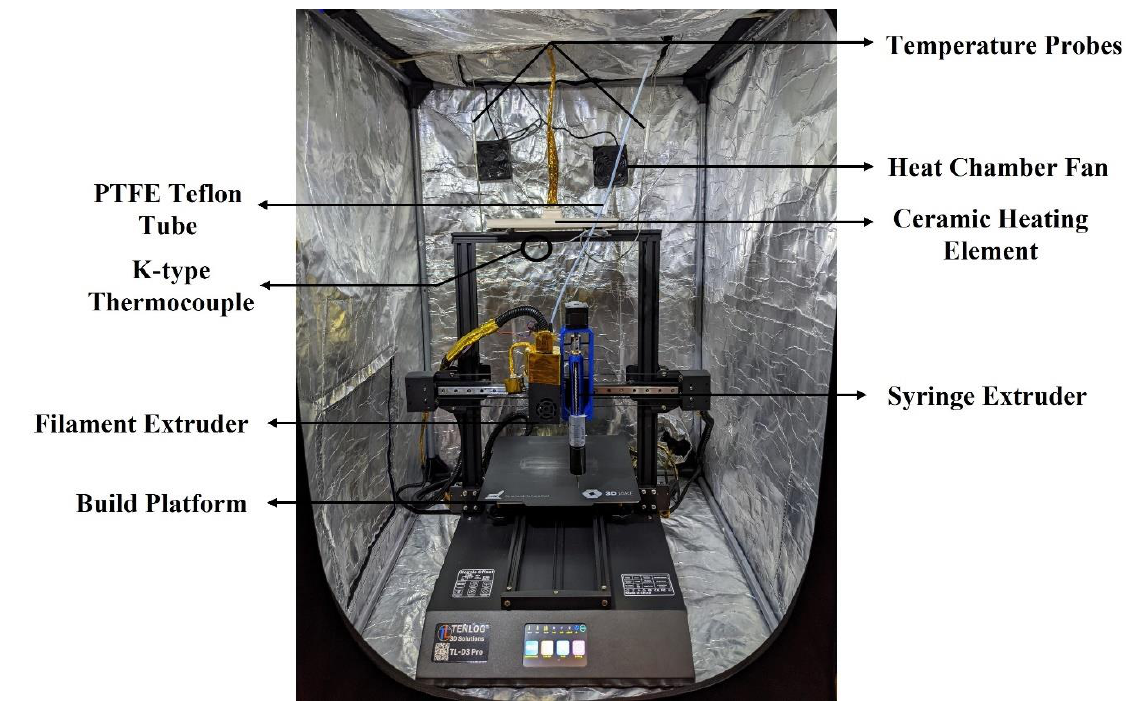
Figure 1. Composite plastic manufacturing process